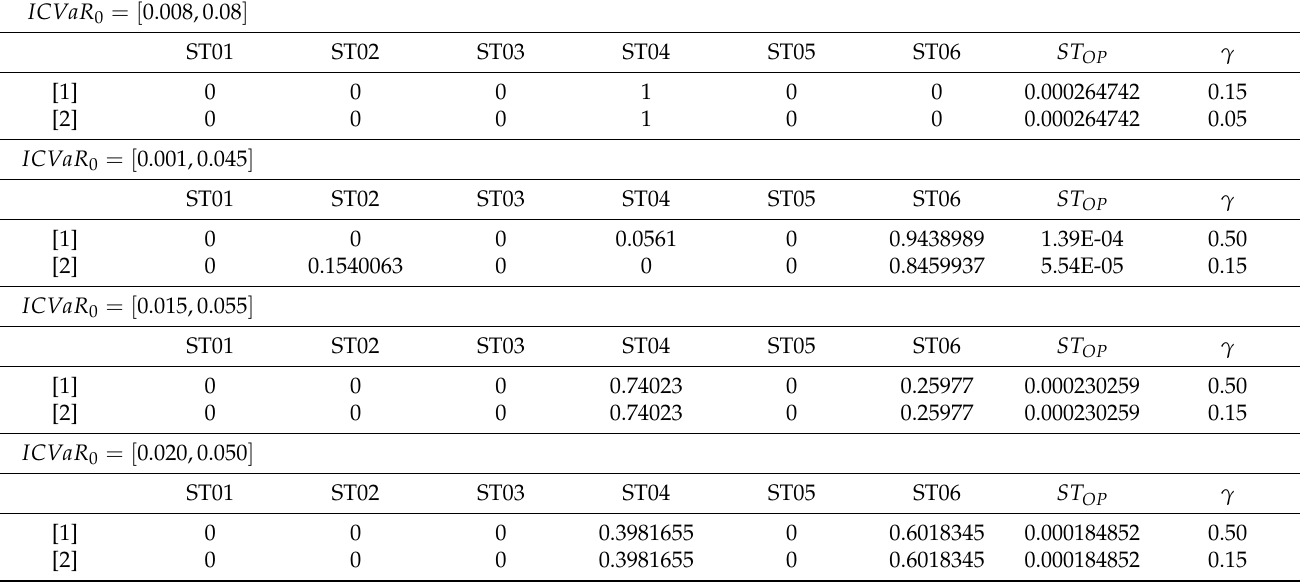
Table 11. Solution of Model 1, data from international markets.